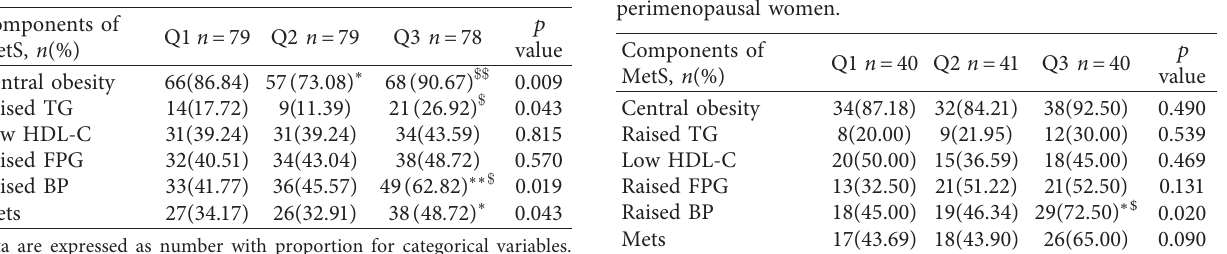
Table 5: The risks of MetS biomarkers according to FSH tertiles